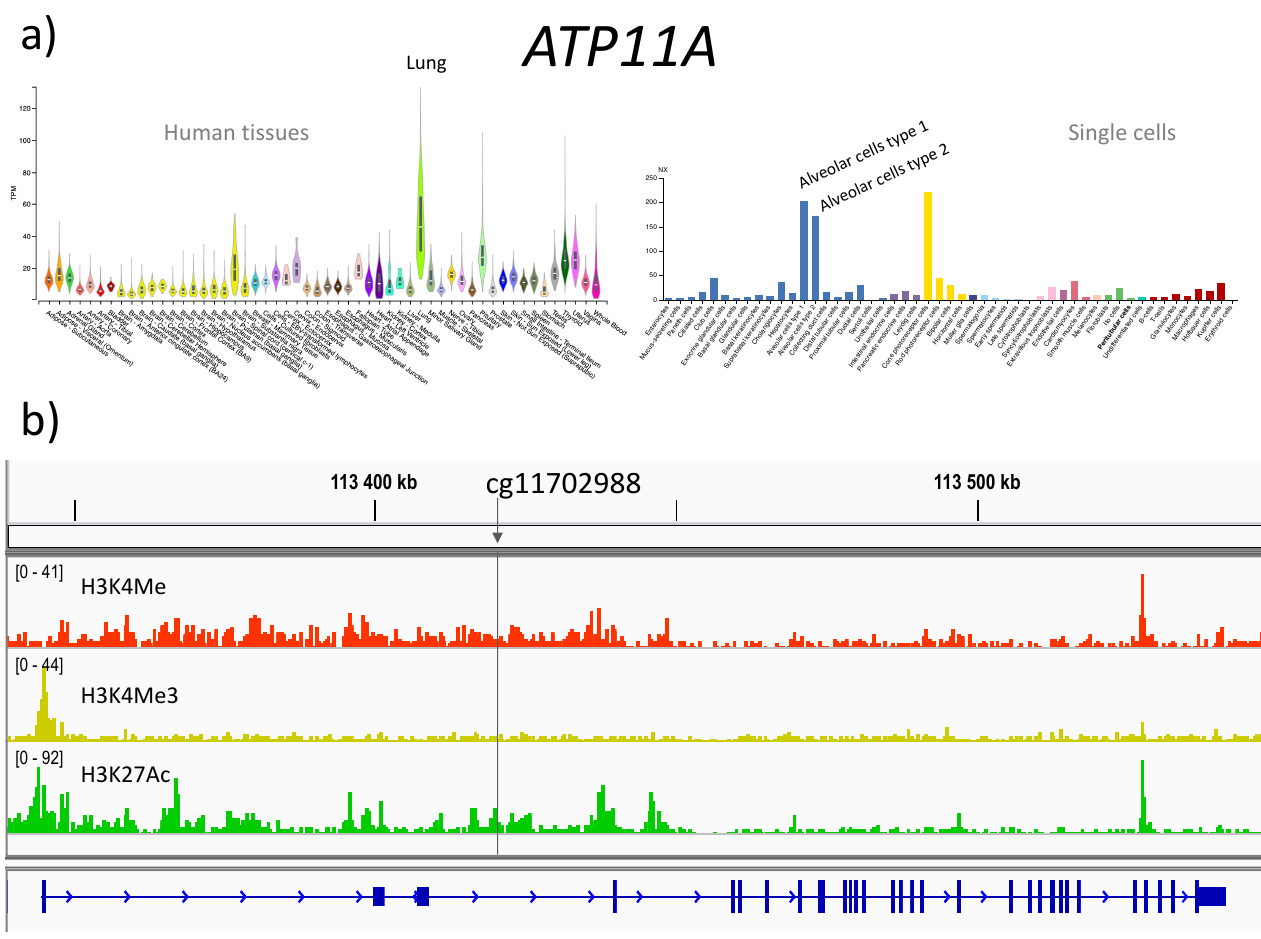
Figure 4. ATP11A gene. ( a ) Gene expression in human tissues (Genotype-Tissue Expression (GTEx) Project [24]) and in single cell RNA-seq datasets (Human Protein Atlas [25]). ( b ) Histone modifications in adult lung are represented with IGV. The vertical line shows the